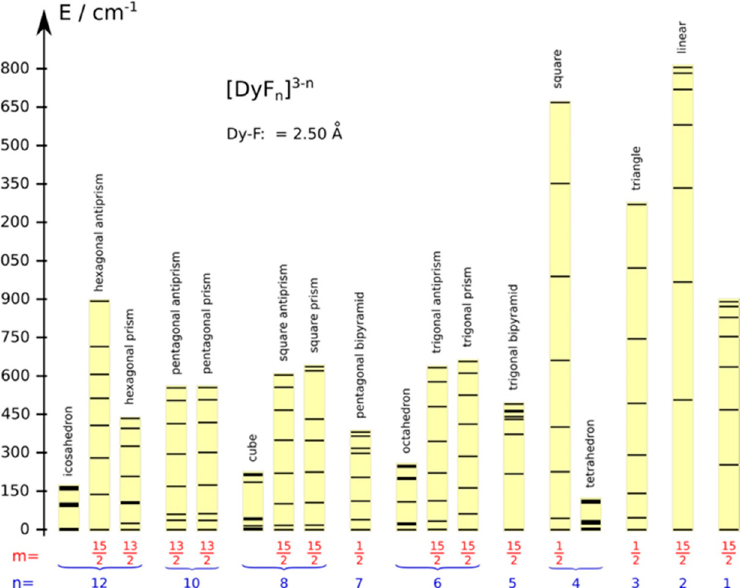
Figure 3. Energy level splitting of M J multiplets in a different coordination number in the hypothetical complex [DyF n ] 3 − n . The figure is reproduced from Reference [26] with permission from the American Chemical Society copyright © 2015.